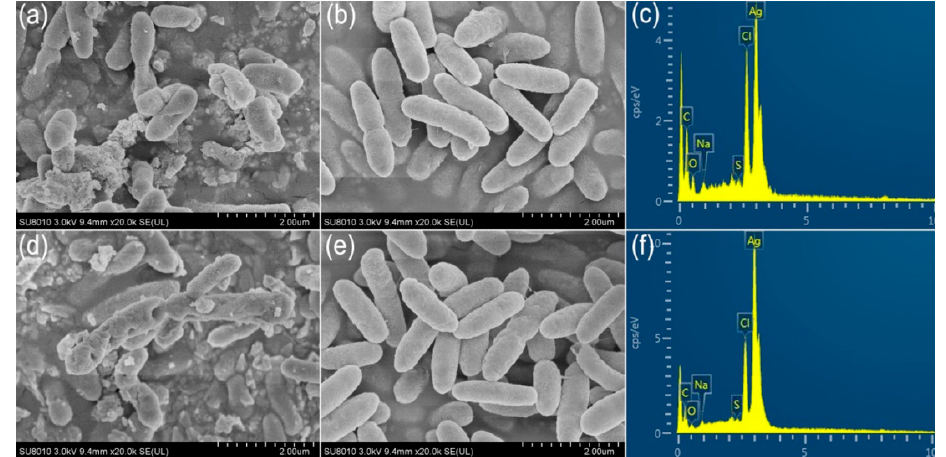
Figure 10. The micrographs of scanning electron microscopy and energy-dispersive spectroscopy ( a , b,d , e ): ( a , b ) SEM analysis; ( a ) treatment by AgCl-NPs and ( b ) CFCS extract for 4 h; ( c ) EDS analysis in ( a ); ( d , e ) SEM analysis; ( d ) treatment by AgCl-NPs and ( e ) CFCS extract for 8 h; ( f ) EDS analysis in ( d